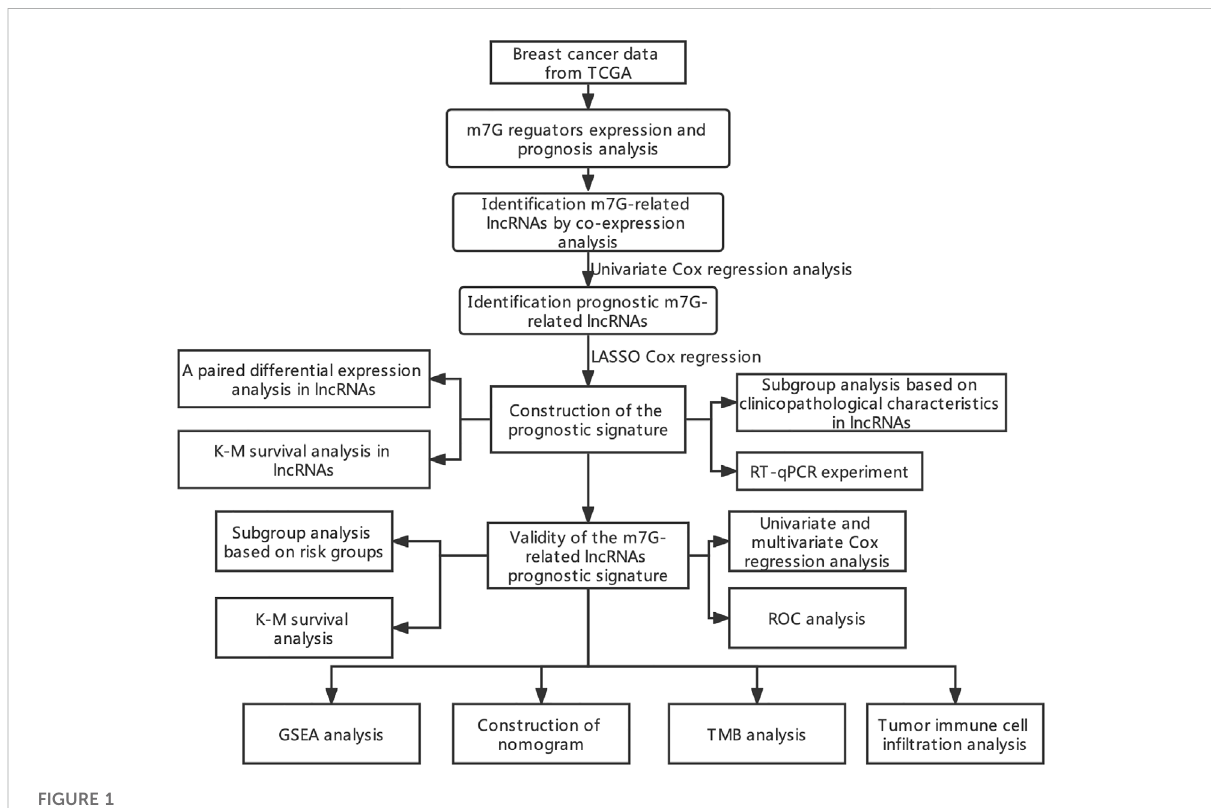
FIGURE 1 Flow chart of the